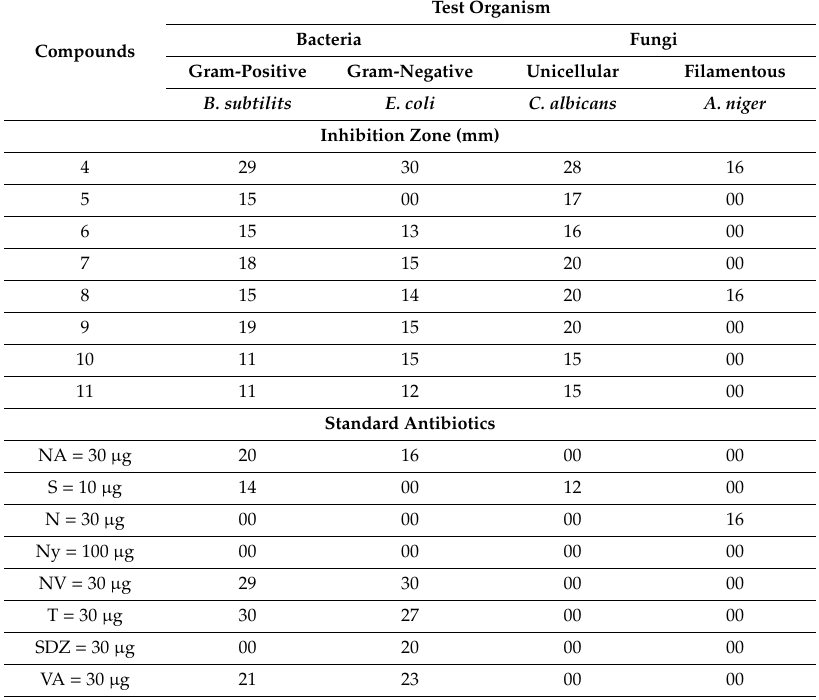
Table 1. The anti-microbial activities of the newly synthesized candidates expressed as inhibition zones of growth in mm against the used test organisms. Test Organism Bacteria Fungi Compounds Gram-Positive Gram-Negative Unicellular